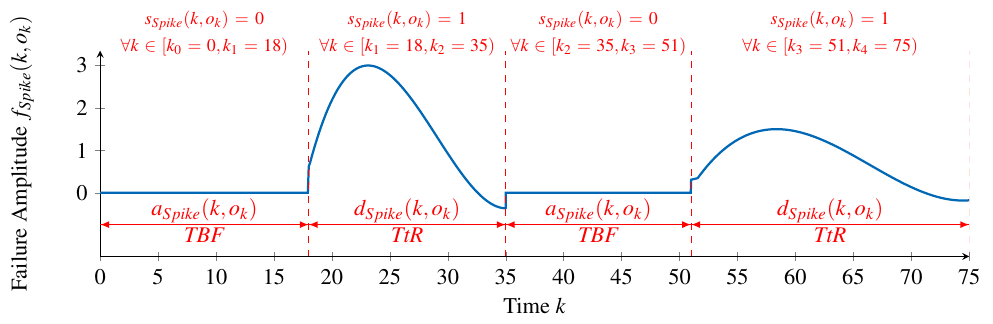
Figure 6. State function for modeling an exemplary Spike failure type with two